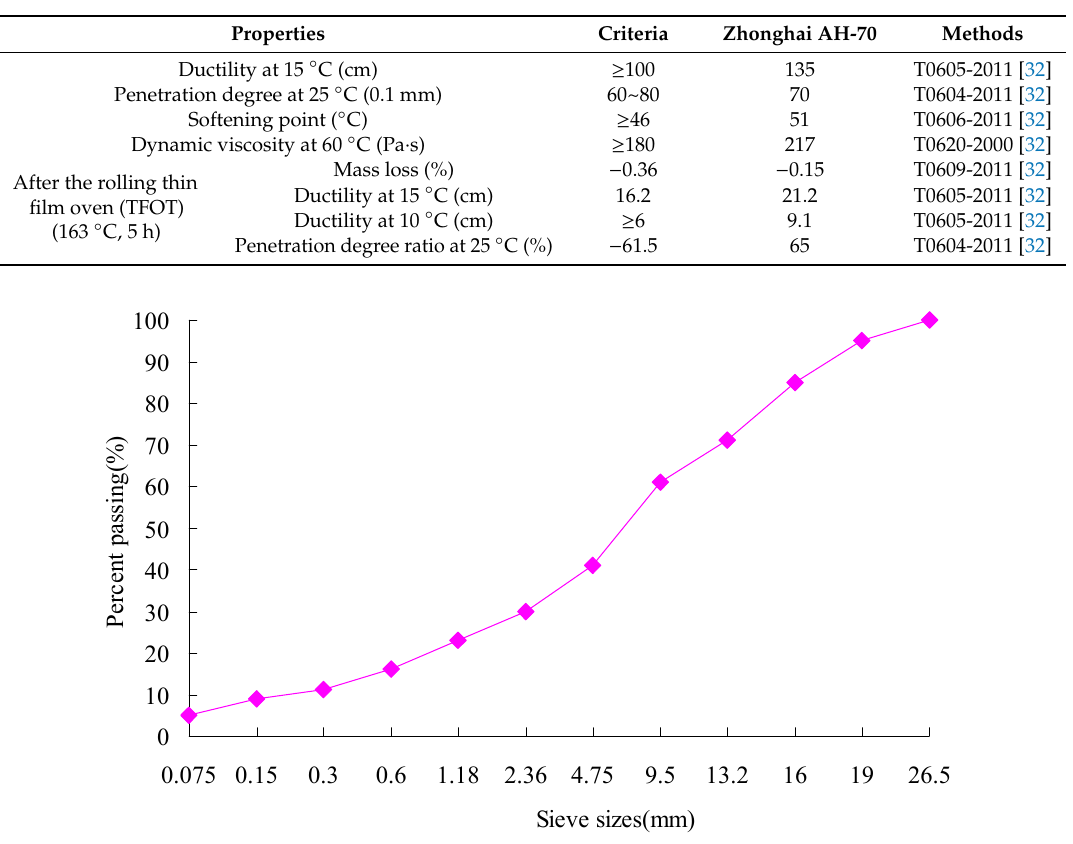
Figure 3. Aggregate gradation of asphalt mixture for test. Table 2. The properties of coarse aggregates.